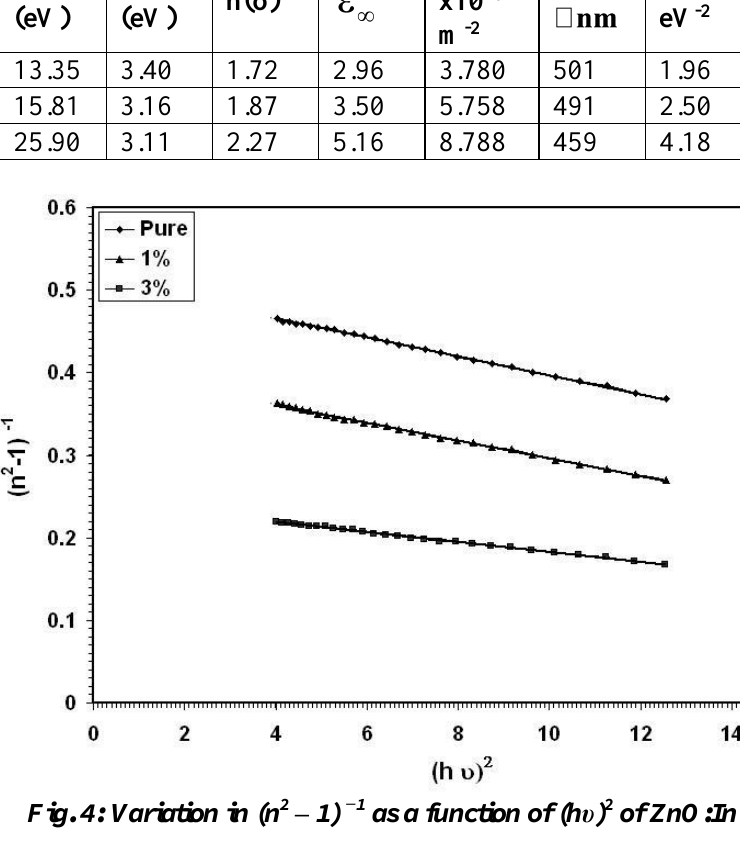
Fig. 4: Variation in (n 2 – 1) −1 as a function of (hυ) 2 of ZnO:In films.